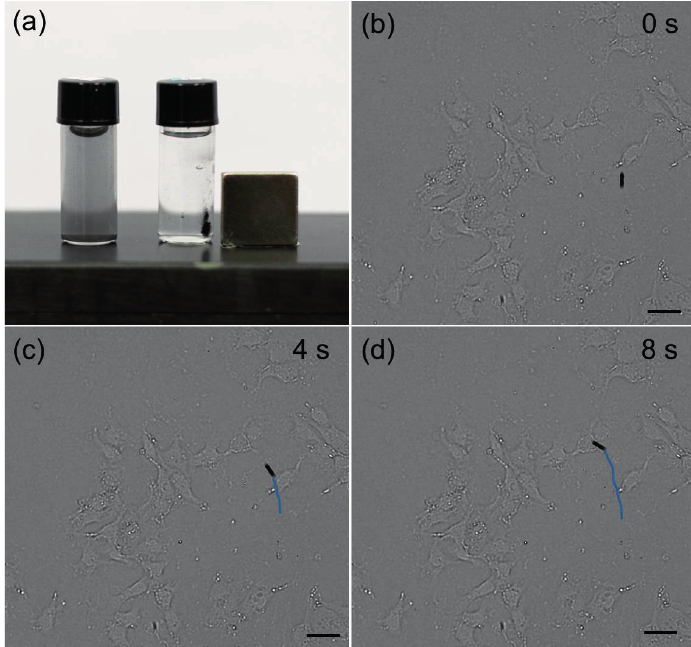
( a ) This photograph showing the aggregation of the Au NPs-(PGA/SPI) micro-tubes under the external magnetic; ( b – d ) Time-lapse images illustrating the movement of a single micro-tube to the HeLa cells, the blue line shows the trajectory of the locomotion of the micro-tube to the HeLa cells under the external magnetic field. Scale bar = 20 μ